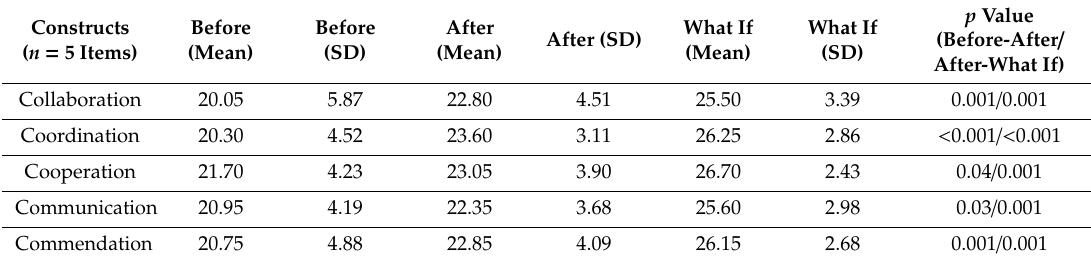
Table 4. The Constructs’ Mean Comparisons (Before, After, and What If) ( n = 20).